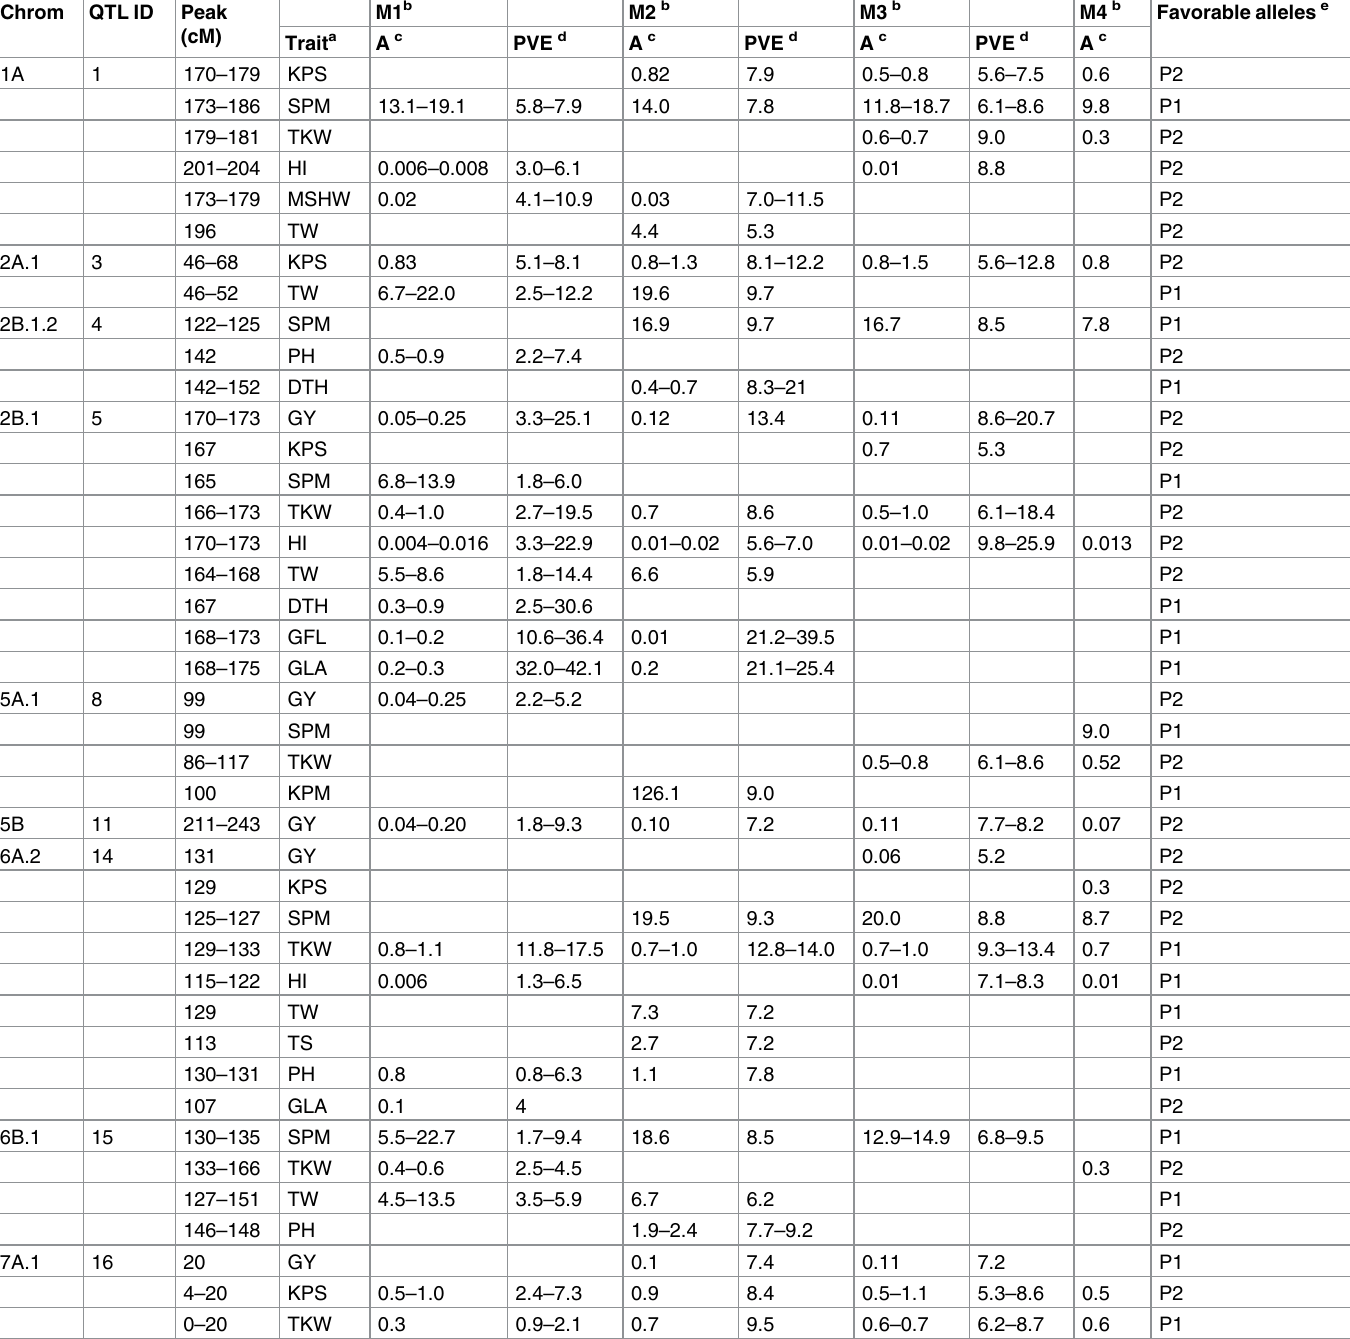
Table 1. Summaryof consistent QTL for yield, yield components and agronomic